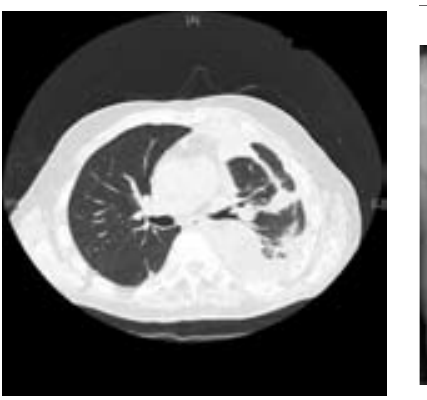
disease.Figure 3. Cytological analysis of the pleu- ral fluid showed plasma cells consistent with